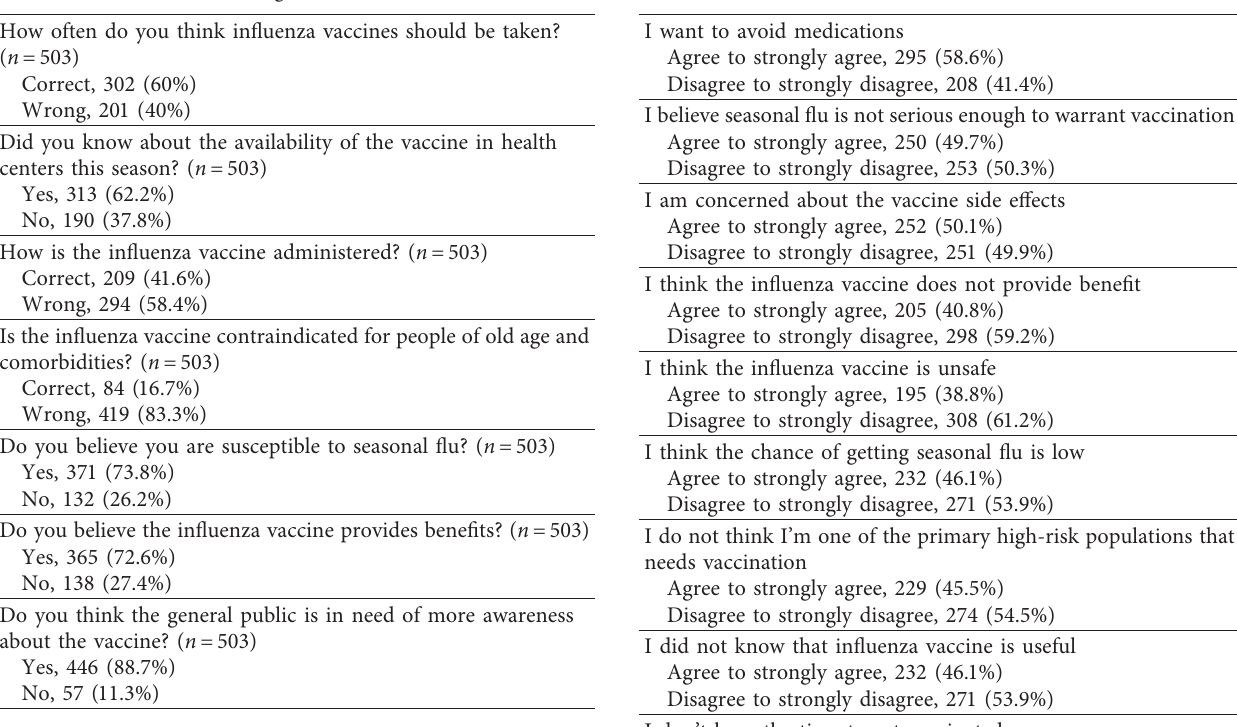
Table 1: Knowledge and attitude, n (%). Table 2: Barriers to seasonal influenza vaccine, n